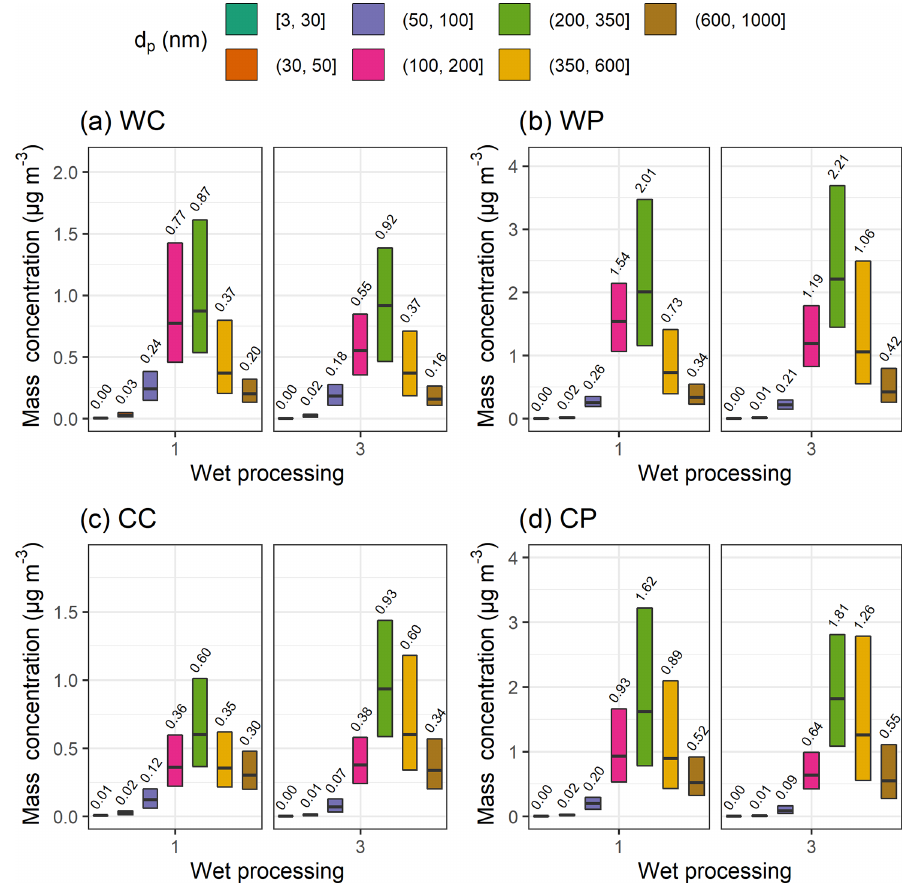
Figure 9. Median (black horizontal lines and numerical values) particle mass concentration with 25th–75th percentiles (boxes) for size bins derived from the DMPS measurements for wet processing groups 1 and 3 as described in Table 1. Subplots show the air mass sectors (clean and polluted) with the seasonal (warm and cold) division: (a) warm and clean, (b) warm and polluted, (c) cold and clean, and (b) cold and polluted. The figure includes all available data between January 2005 and August 2019. Note the different y -axis scale in each